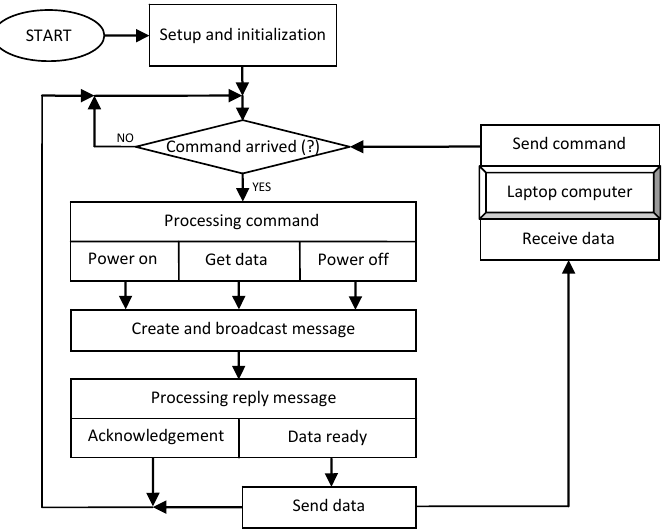
Figure 5. Window of the application serving the request center. Buildings 2020 , 10 , x FOR PEER REVIEW